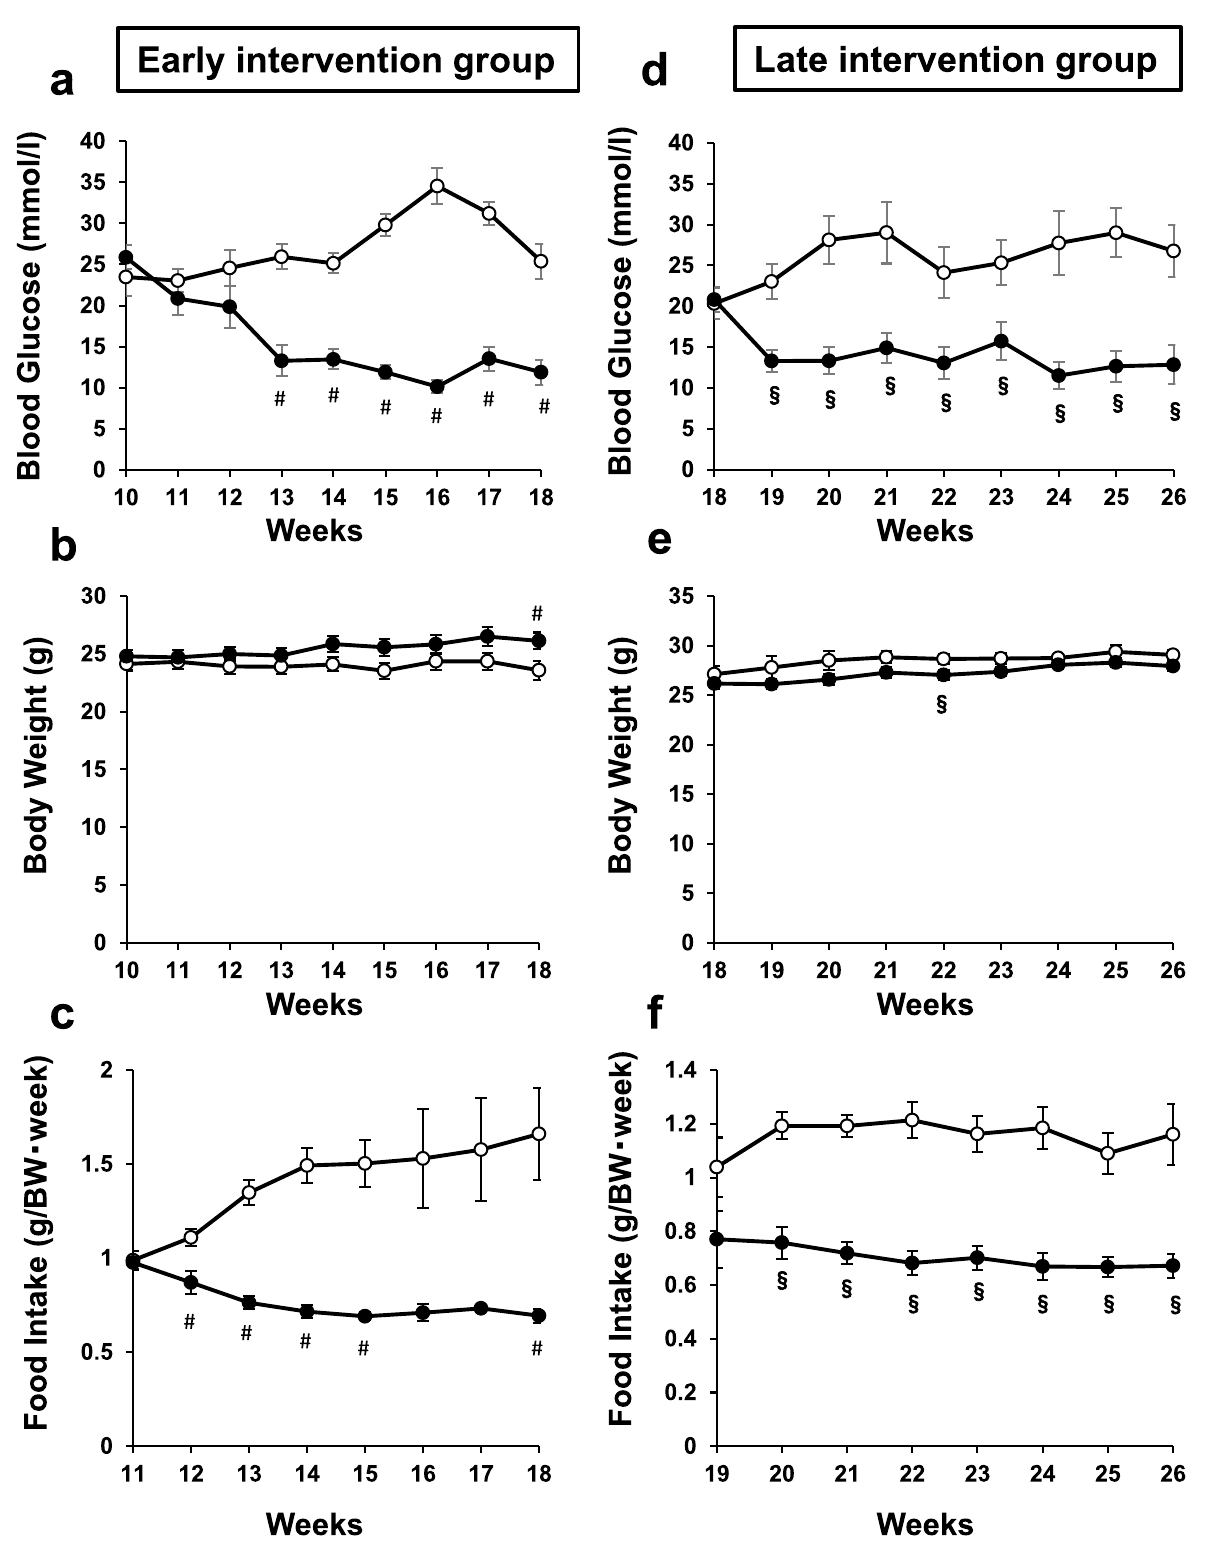
Figure 1. Blood glucose levels, body weights and food intake in an early and a late intervention group in STZ- induced ApoE knockout mice. STZ-induced diabetic ApoE knockout mice were subcutaneously injected either Dula (0.6 mg/kg × 2/week) or vehicle in an early and a late intervention group. ( a ) Blood glucose levels, ( b ) body weights and ( c ) food intake in an early intervention group. Dula (black circle) (n = 9), control (white circle) (n = 9). ( d ) Blood glucose levels, ( e ) body weights and ( f ) food intake in a late intervention group. Dula (n = 8), control (n = 10). Values are the mean ± SEM of data obtained from each group. # p < 0.05 (Early Cont vs Early Dula), § p < 0.05 (Late Cont vs Late